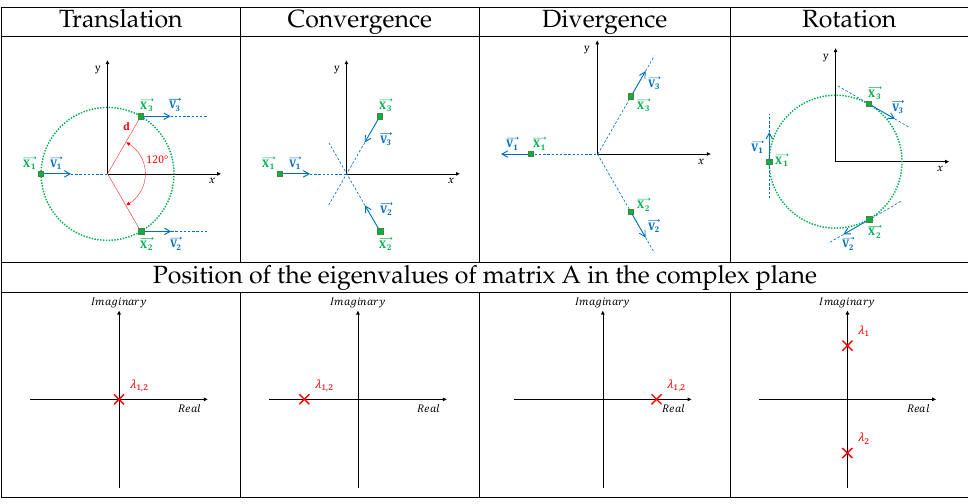
Figure 4. Eigenvalues loci for 4 traffic